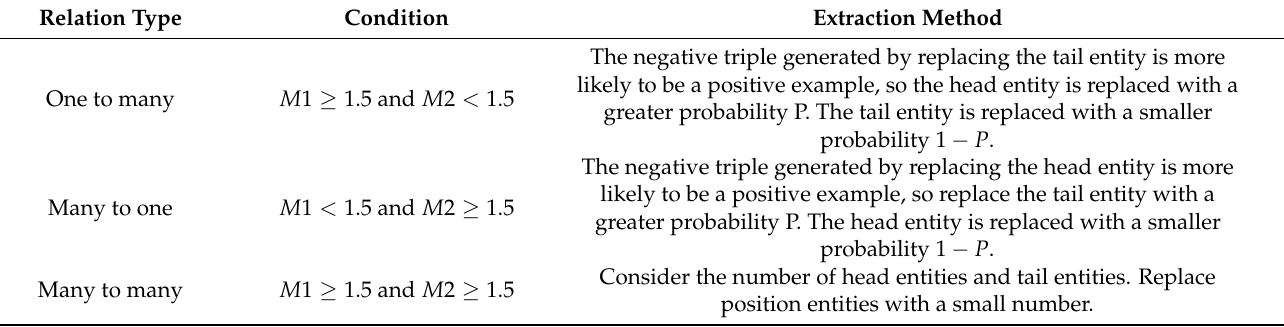
Table 1. Sampling methods for different relation mapping